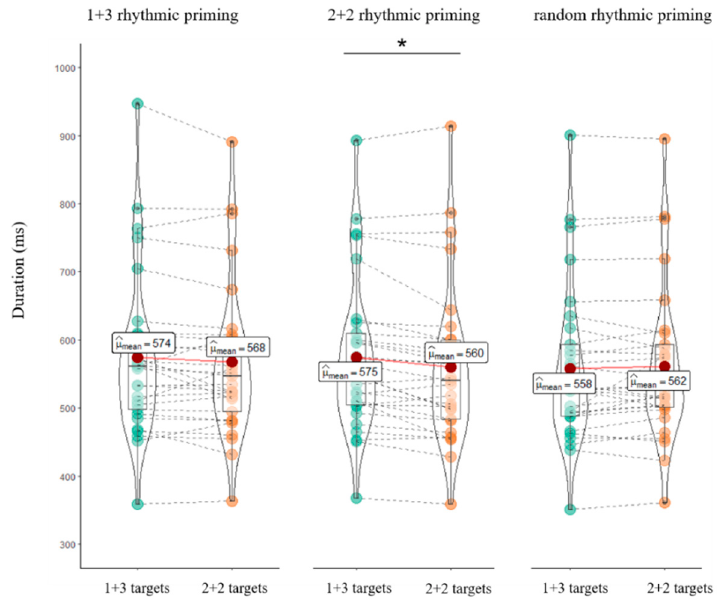
Figure 2. The differences in target conditions for each prime rhythm pattern across all of the partic- ipants. The points indicate averages for each participant; dark-red circles represent means; the solid red lines connecting the dark-red circles visually reveal the differences between the mean reaction time of different conditions; the dashed gray lines connecting the green or yellow points indicate scores for the same participant; and the boxplots represent the medians and interquartile ranges. * p < 0.05.